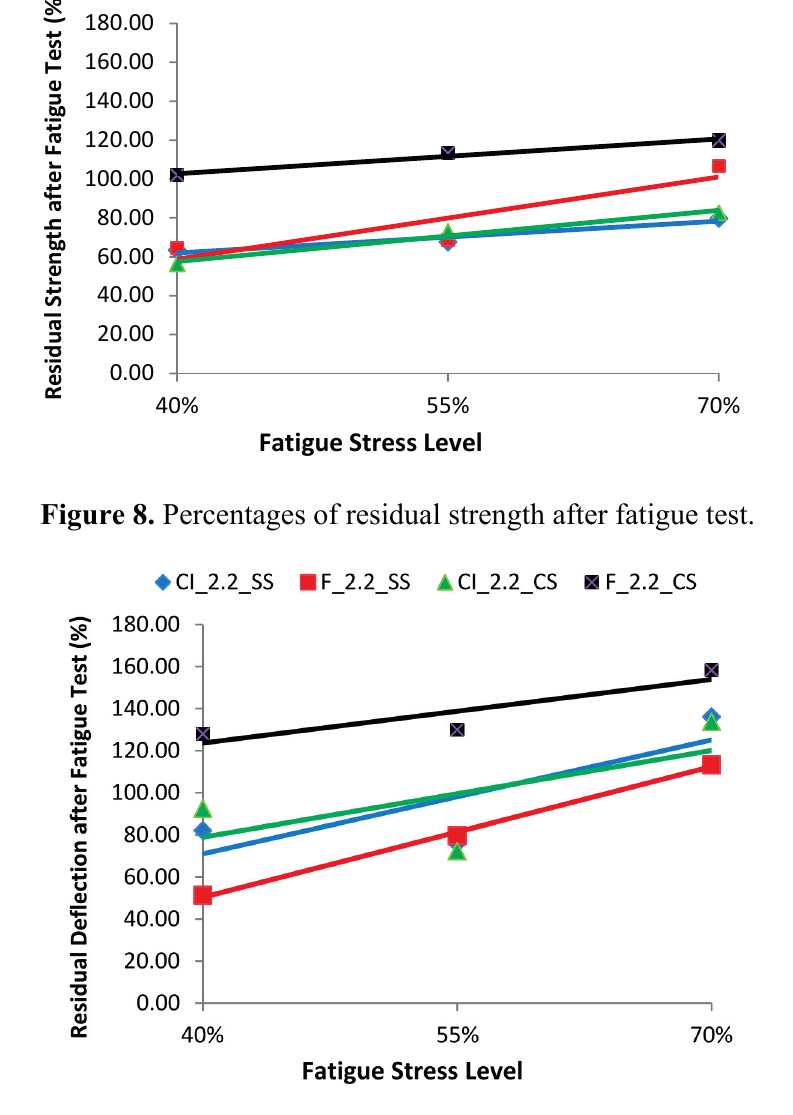
Figure 9. Percentages of residual mid-span deflection after fatigue